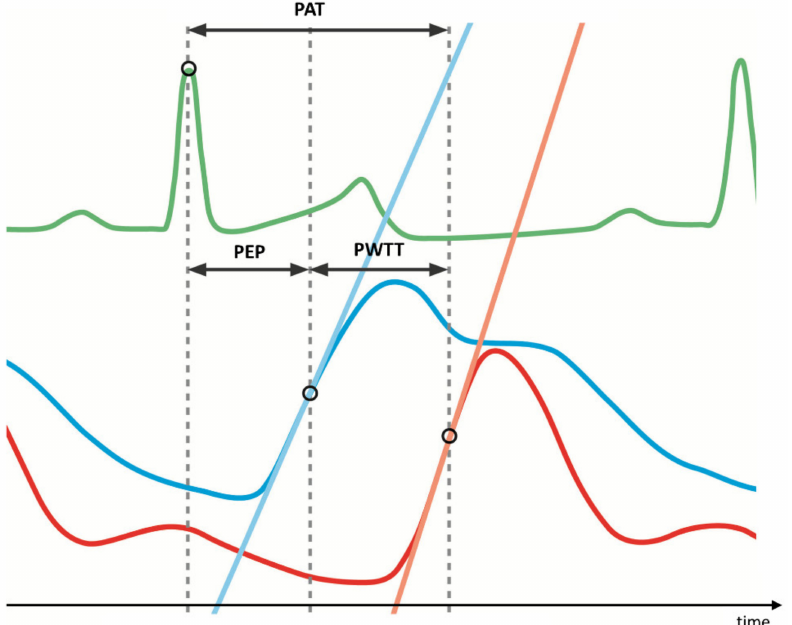
Figure 1. PAT is the sum of PEP (pre-ejection period—details see below) and PWTT. The pulse arrival time (PAT) is defined as the time interval between the R-spike of the ECG (green) and the pulse arrival at the distal pulmonary artery catheter (red). In this example the timespan between the R-spike of the ECG and the pulse arrival in the proximal pulmonary artery (blue) is equivalent to the PEP, as the catheter is placed right behind the pulmonary valve. The pulse propagation from the proximal pulmonary artery (blue) to the distal pulmonary artery (red) is called pulse wave transit time (PWTT). This PWTT, as well as the PAT, can be calculated without knowledge of the exact localization of the respective pressure probes. When the exact distance between the proximal and the distal catheter position (PD) is known, pulse wave velocity (PWV) can be calculated as: PWV = PD/PWTT